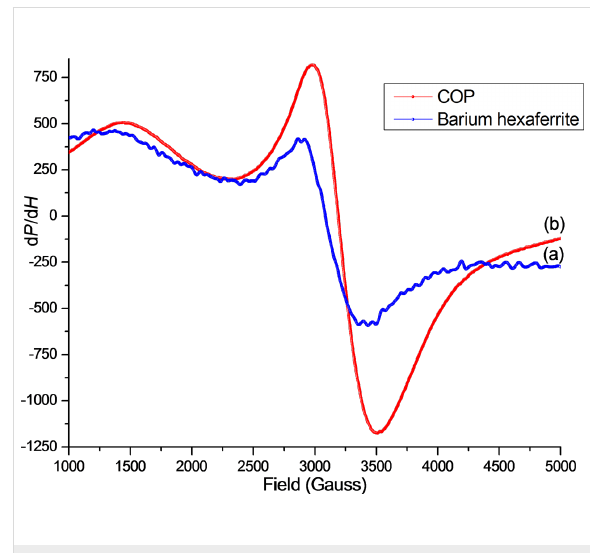
Figure 3: ESR spectra for (a) barium hexaferrite and (b) composite COP at room temperature in the X band.